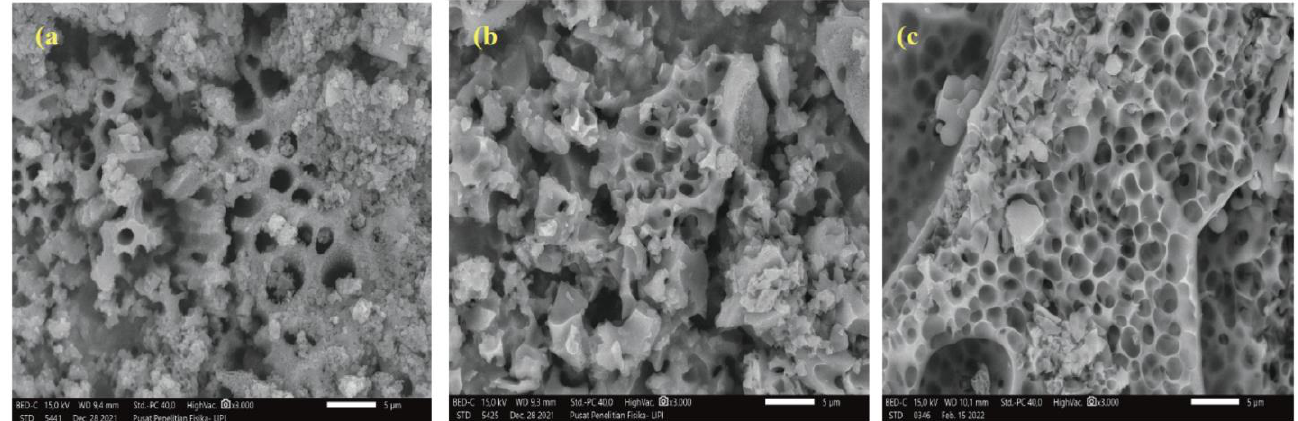
Figure 2. Morphological images (SEM) of the obtained rhodamine derivatives: ( a ) Rh-S, ( b ) Rh-S5, and ( c )